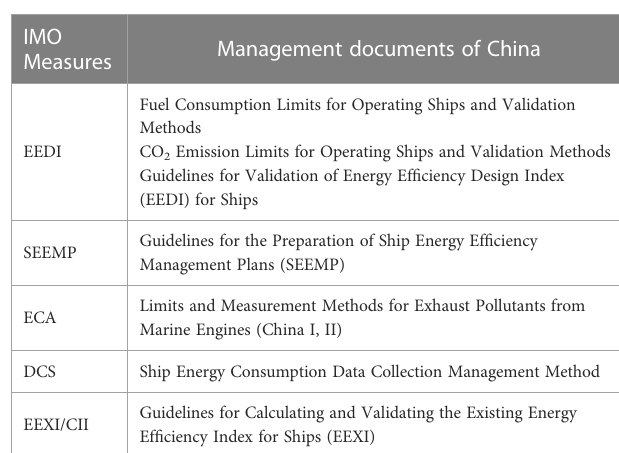
TABLE 1 China ’ s translational application of IMO